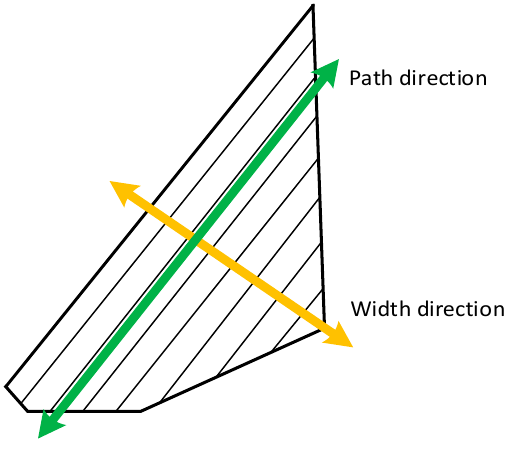
Figure 2. Optimal path division.